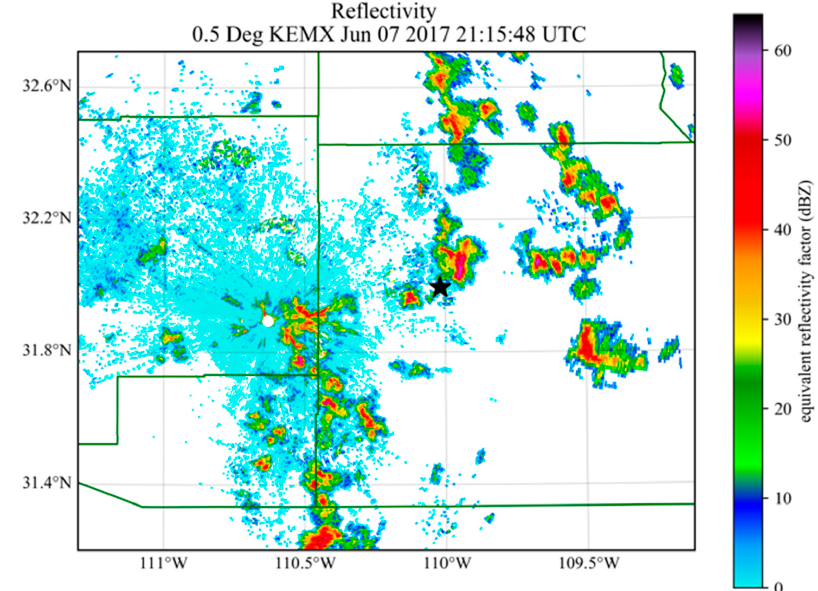
Figure 9. Base reflectivity (dBZ) of multiple cells from the WSR-88D radar in Tucson, AZ [45]. The black star denotes the location where the Lizard Fire started near the time of the lightning strike that caused the fire.